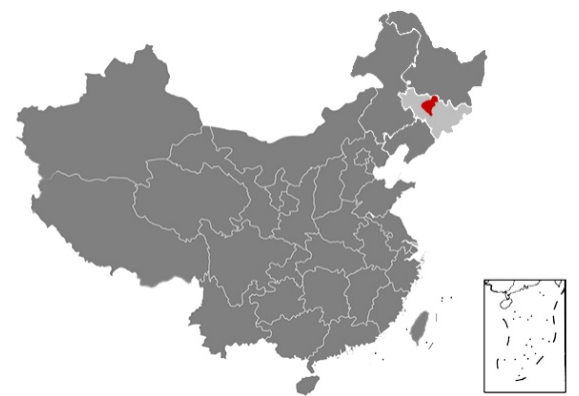
Figure 3. Location of Changchun in China.